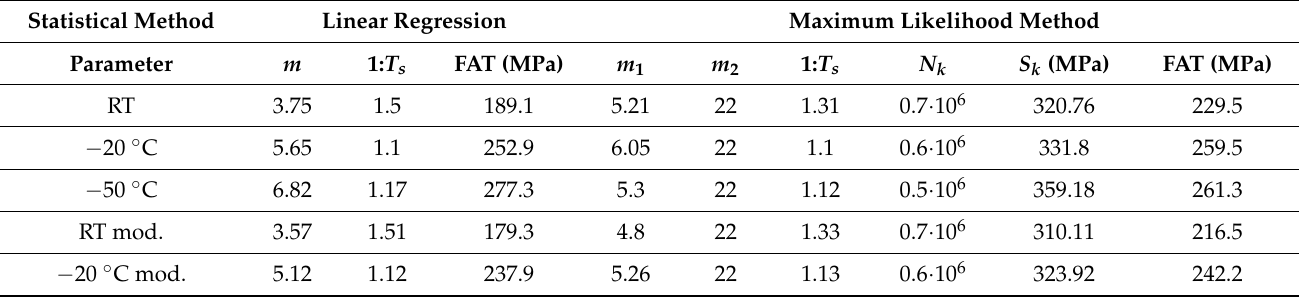
Table 2. S-N curve parameter evaluated with linear regression and with maximum likelihood method for all test series. “mod.” refers to the actual crack position, i.e., the modified stress.